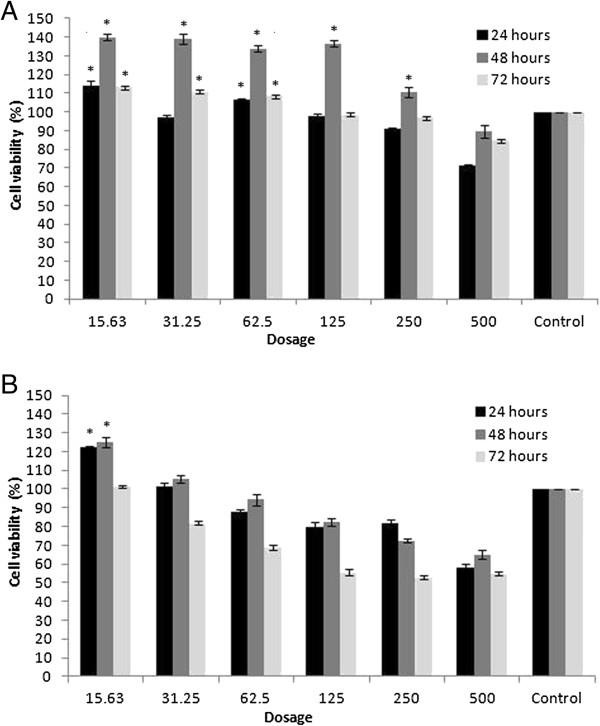
Percentage of Vero cells viability at different times of incubation and dosages of Phyllanthus treatments. (A) Vero cells treated with aqueous cocktail extract of Phyllanthus and (B) Vero cells treated with methanolic cocktail extract of Phyllanthus. Results are expressed as mean ± SEM of three independent experiments. * signifies p < 0.05 compared to the untreated control.